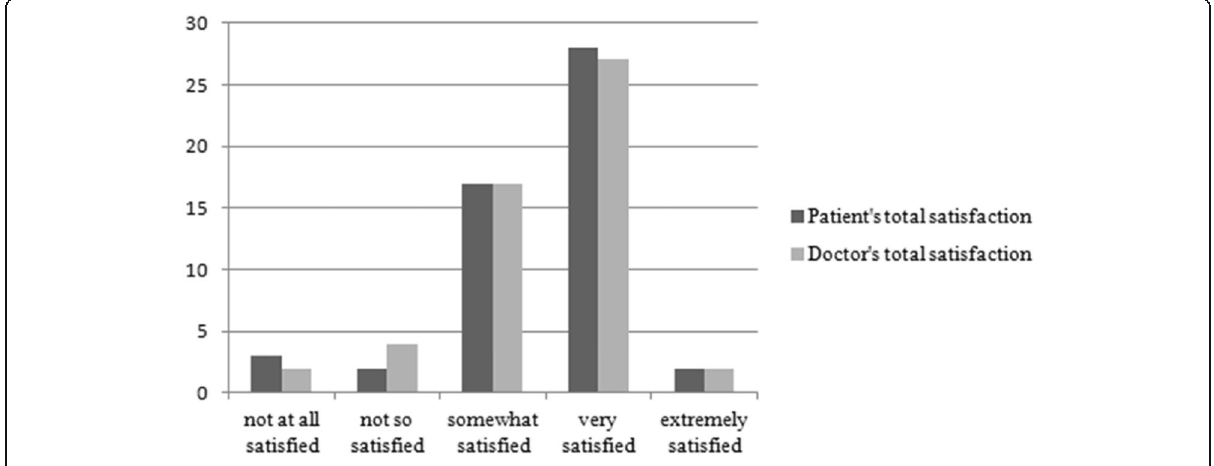
Fig. 2 Patients ’ and Doctors ’ Total Satisfaction with Treatment ( N = 52)